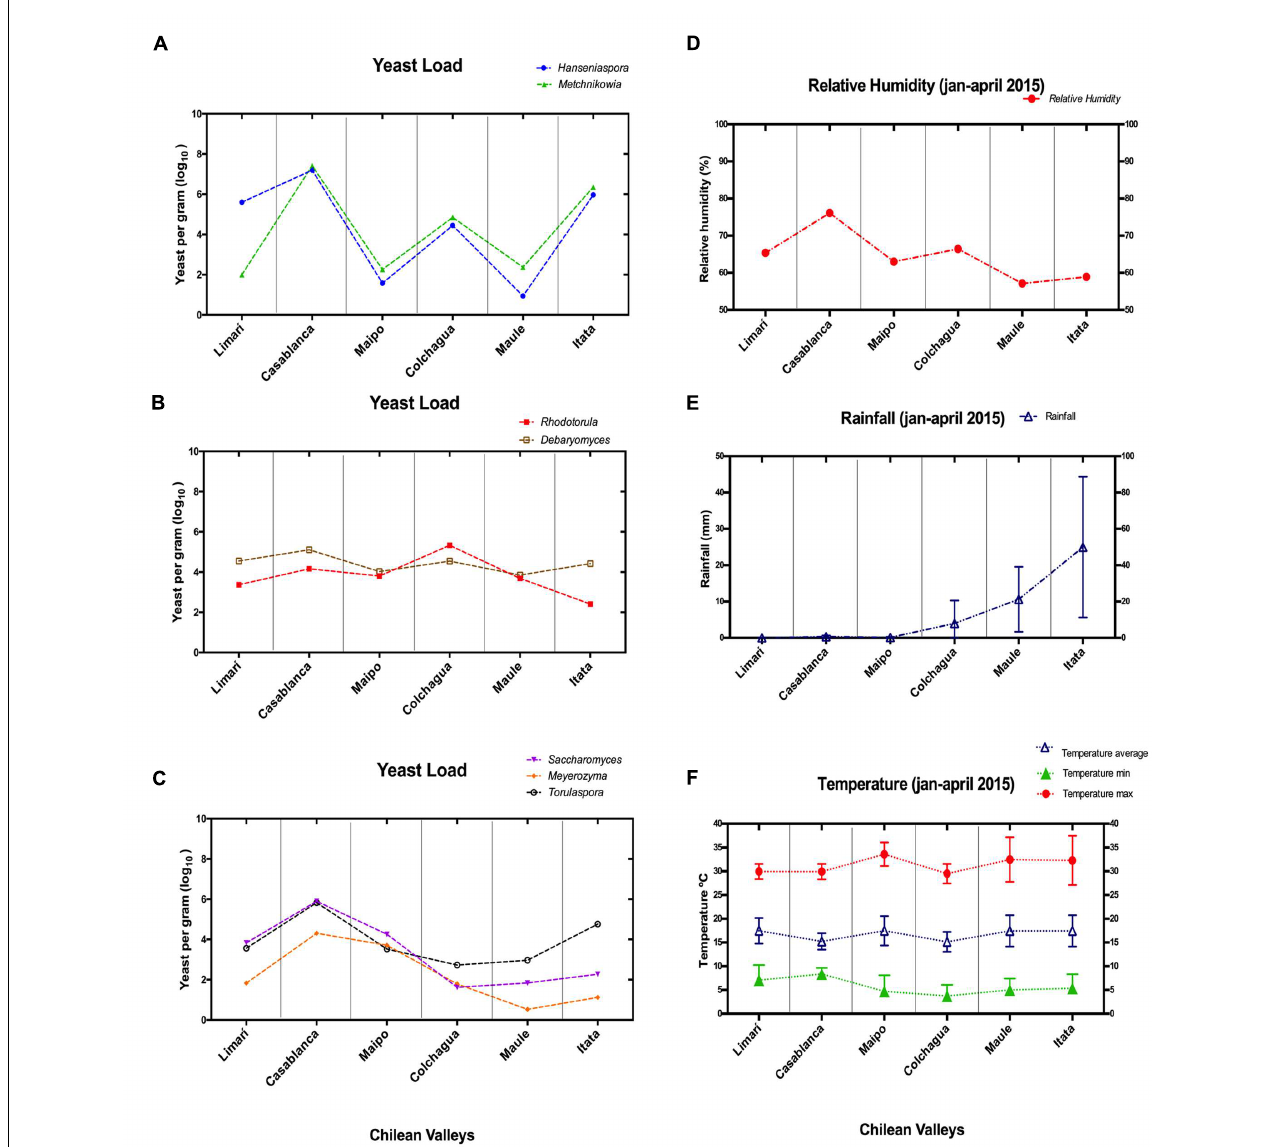
FIGURE 2 | Non-conventional yeast loads and climatic factors in Chilean valleys. (A–C) Correspond to qPCR data expressed as yeast per grams (scale log 10 ). (A) Hanseniaspora/Metschnikowia ; (B) Torulaspora/Saccharomyces/Meyerozyma ; (C) Rhodotorula/Debaryomyces . (D–F) Correspond to climatic factors. (D) Relative humidity (%); (E) Rainfall (mm); (F) Temperature (Celsius